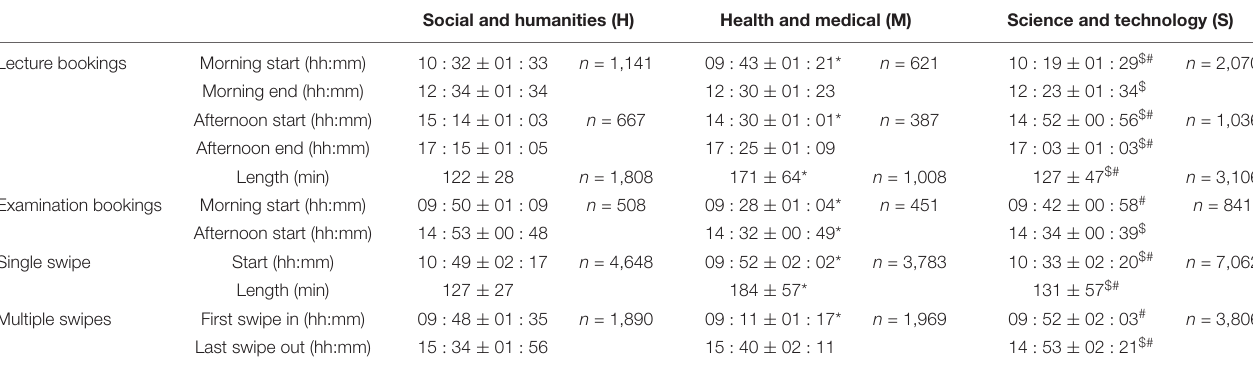
TABLE 3 | Lecture and examination booking times, plus electronic attendance records, by study